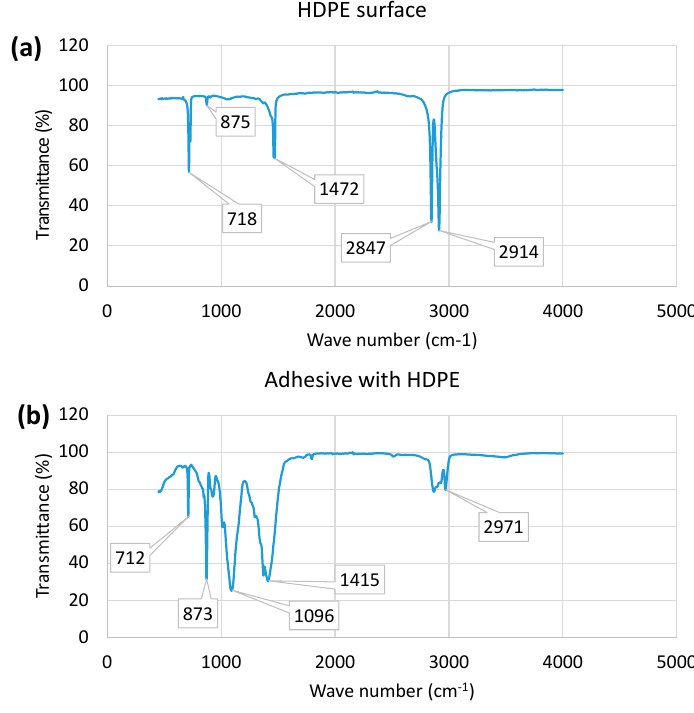
Figure 18. FTIR spectra of the HDPE and adhesive used in the laminates.